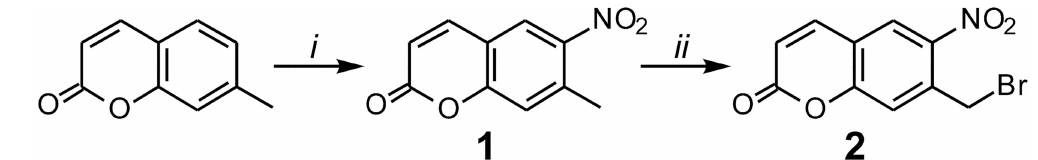
Fig 1. Synthesis of the caging reagent: Ncm bromide. Reagents and conditions: i ) KNO 3 , concentrated H 2 SO 4 , 0˚C, 1 h; ii ) NBS, benzoyl peroxide, CCl 4 , reflux, 30 h.